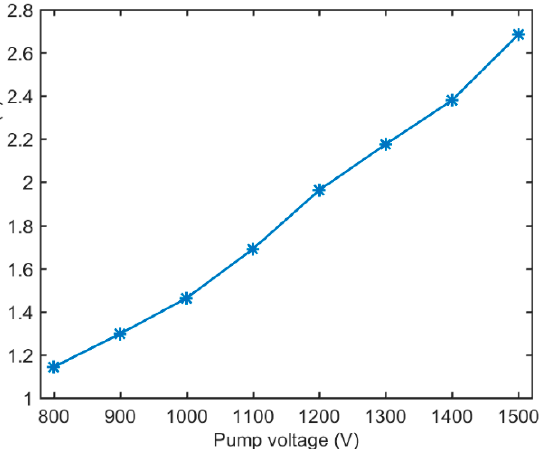
Figure 14. Wavefront aberration versus pump voltage with the cooling flow rate of 6 L/min.